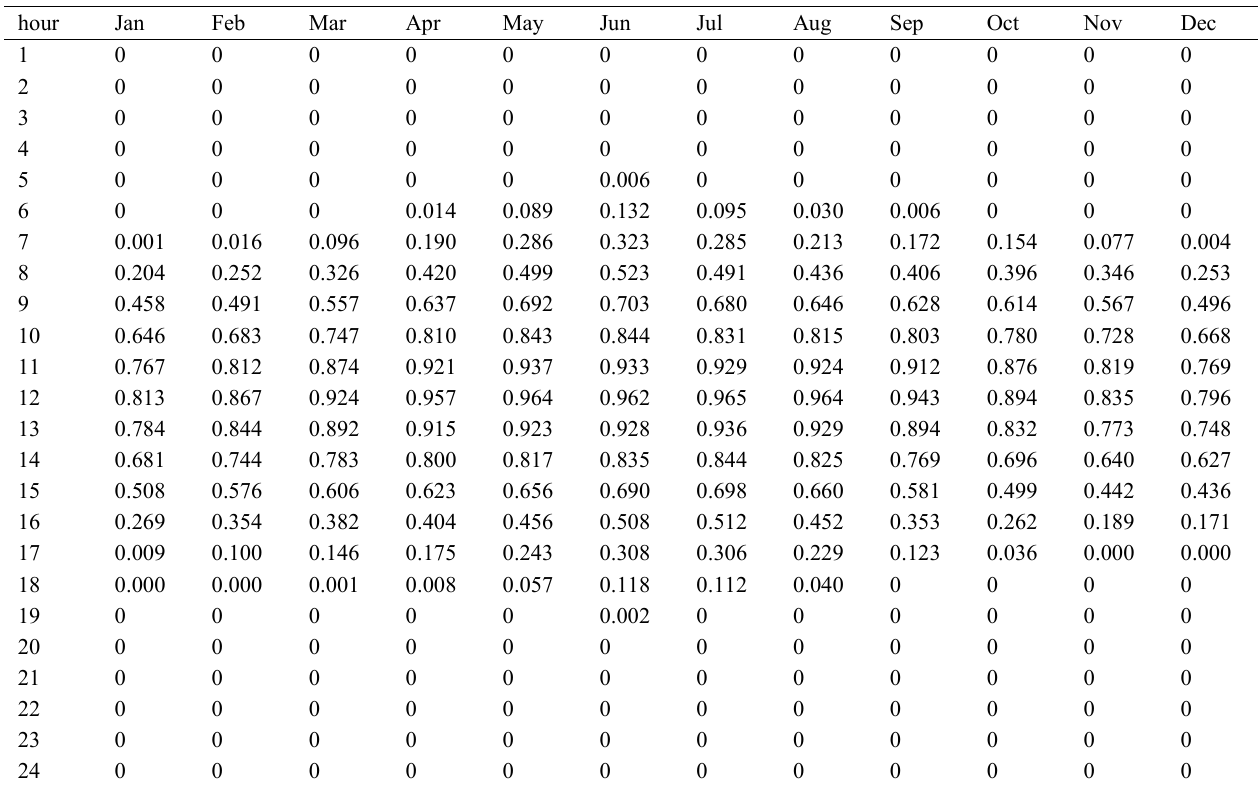
Figure 15. Daily hourly solar radiation for each month with optimum tilt angle using MATLAB program in California city. Table 8. Optimized solar radiation data for California city in kW/m 2